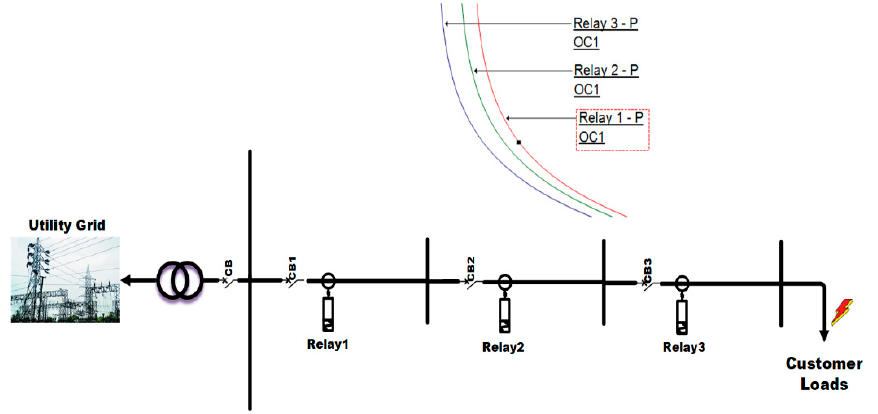
Figure 8. Traditional coordination of protective relays.